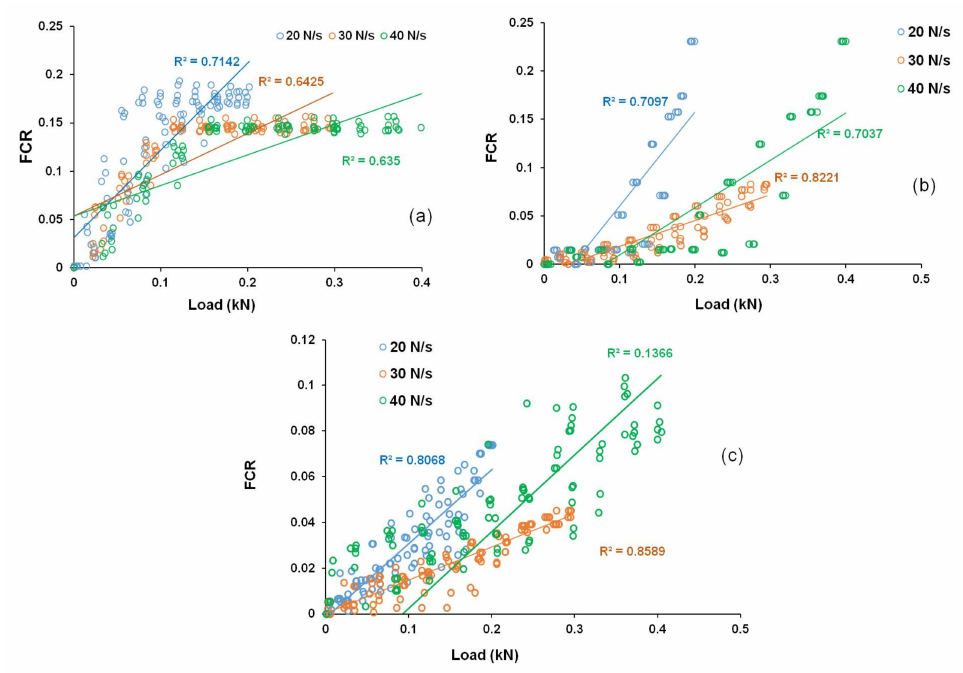
Figure 16. FCR-load correlation of cementitious composites containing different carbon fiber contents: ( a ) 0.25 wt.%, ( b ) 0.5 wt.% and ( c ) 0.75